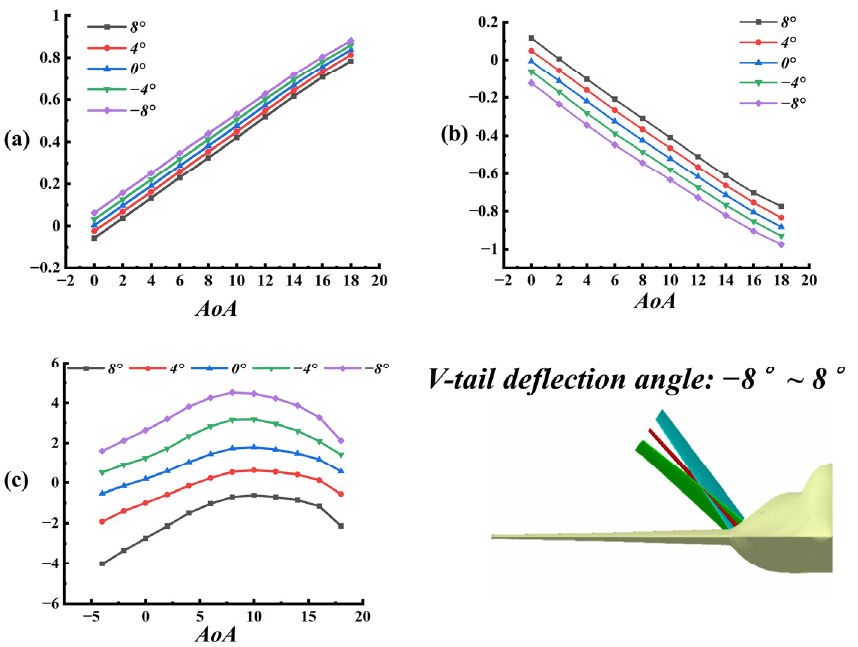
Figure 3. CFD calculation process: ( a ) the path lines and ( b ) the aerodynamic coefficient iteration process.